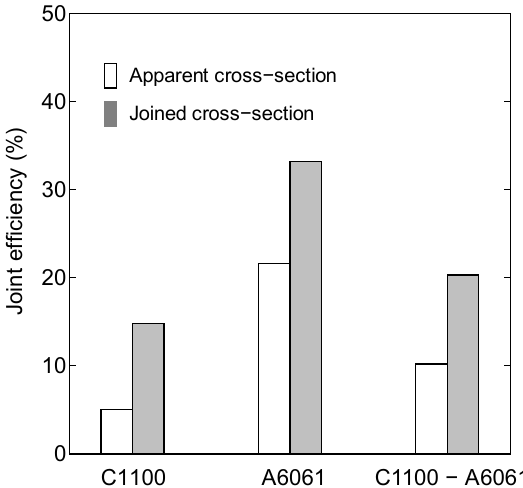
Figure 6. Joint efficiency of three different combinations.